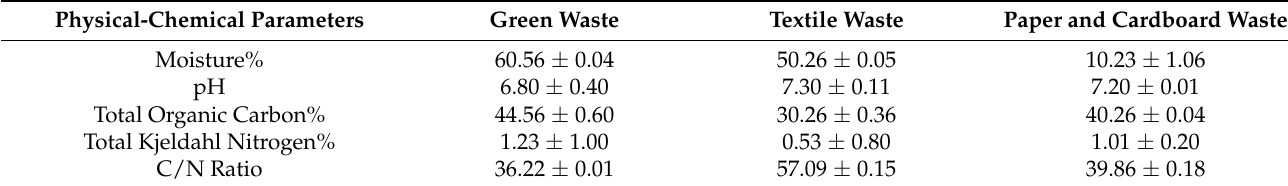
Table 1. Feedstock physical-chemical characteristics.